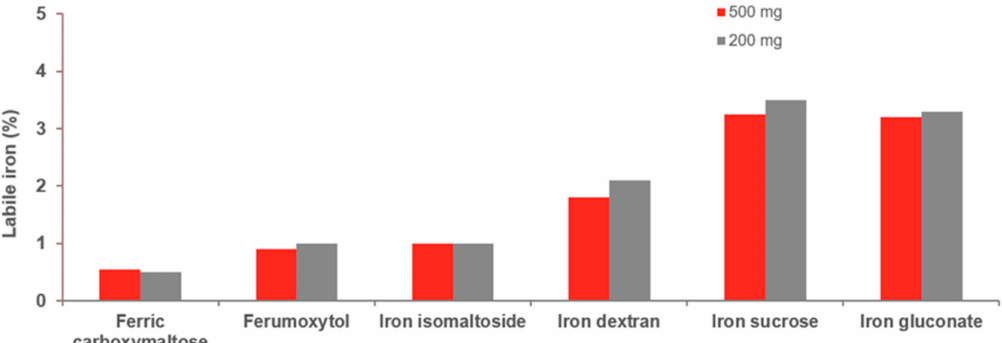
Figure 3. In vivo comparison of labile iron potential of IV iron preparations. Results of the determination of detectable labile iron in human serum as a percentage of total dose given (200 mg and 500 mg), using the Ferrozine ® -method (adapted from Jahn et al., 2011